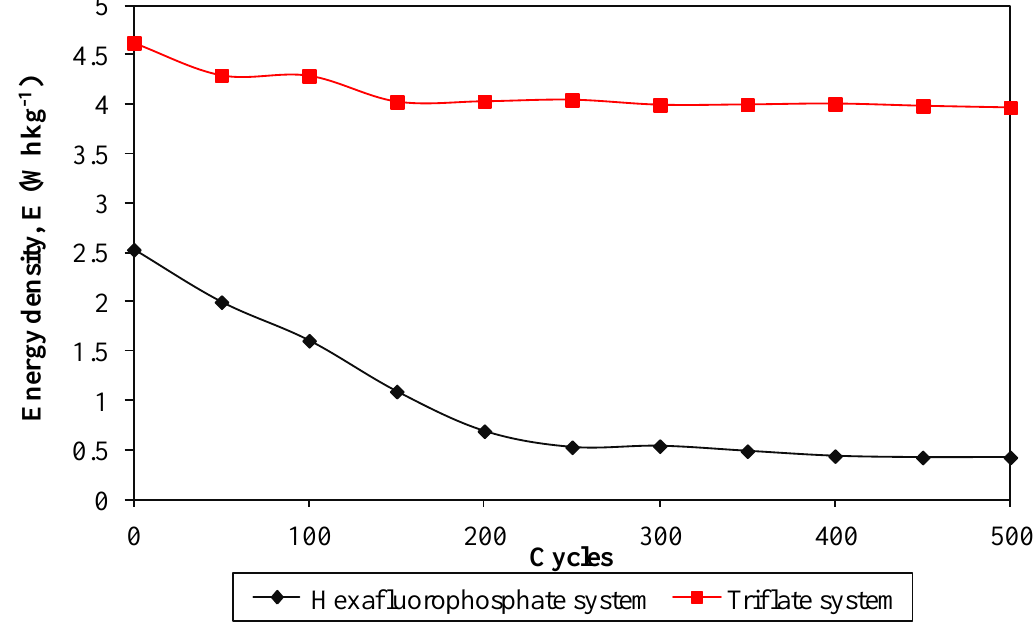
Figure 10. Energy density of different ionic liquid-based biopolymer electrolyte systems over 500 cycles.